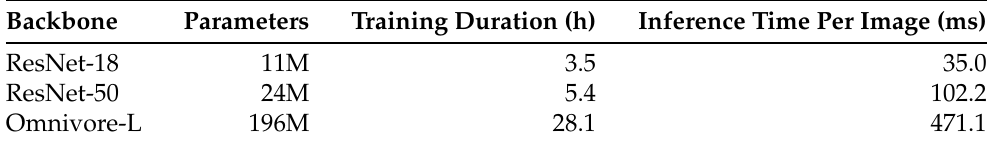
Table A2. Benchmarks of the two ResNet [63] and the Omnivore-L [19] backbones on a single NVIDIA Quadro RTX